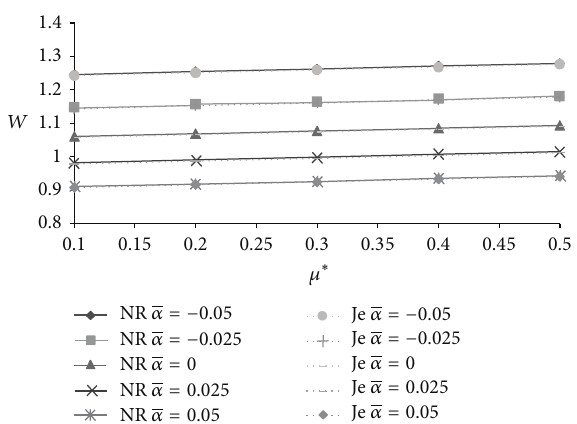
Figure 6: Variation of load carrying capacity with respect to 𝜇 ∗ and 𝛼 .